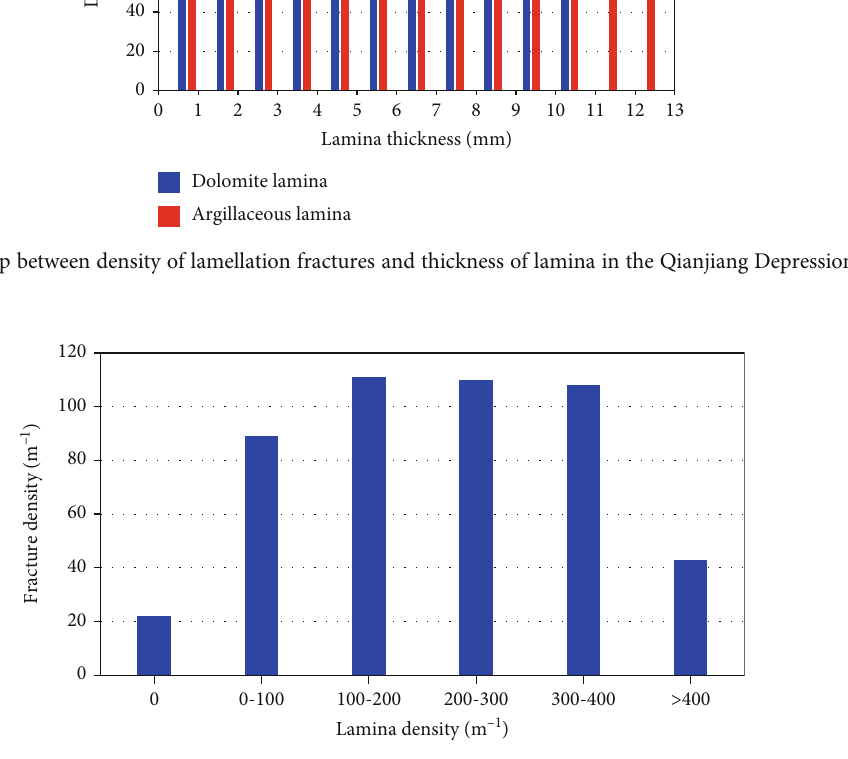
Figure 10: Relationship between density of lamellation fractures and lamina in the Qianjiang Depression ( N = 828 ).